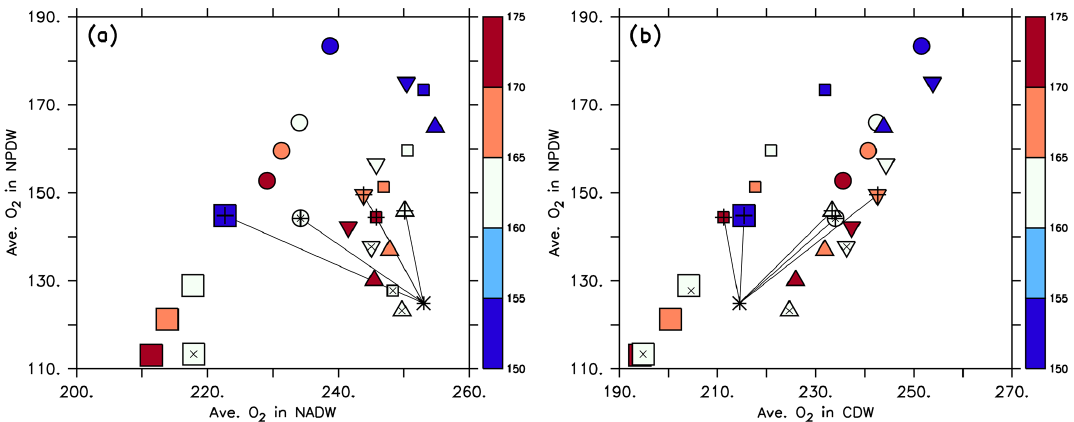
Figure 9. As Fig. 8, but for average oxygen and parameter R − O